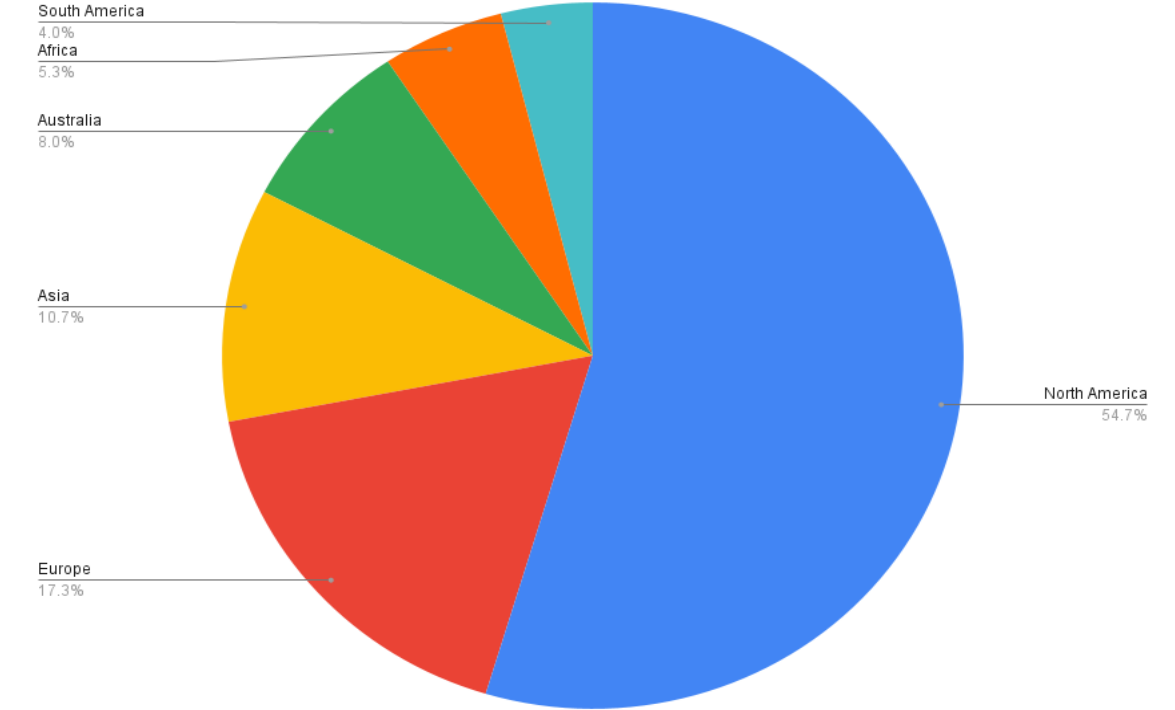
Figure 2. Summary of Continents selected for Study